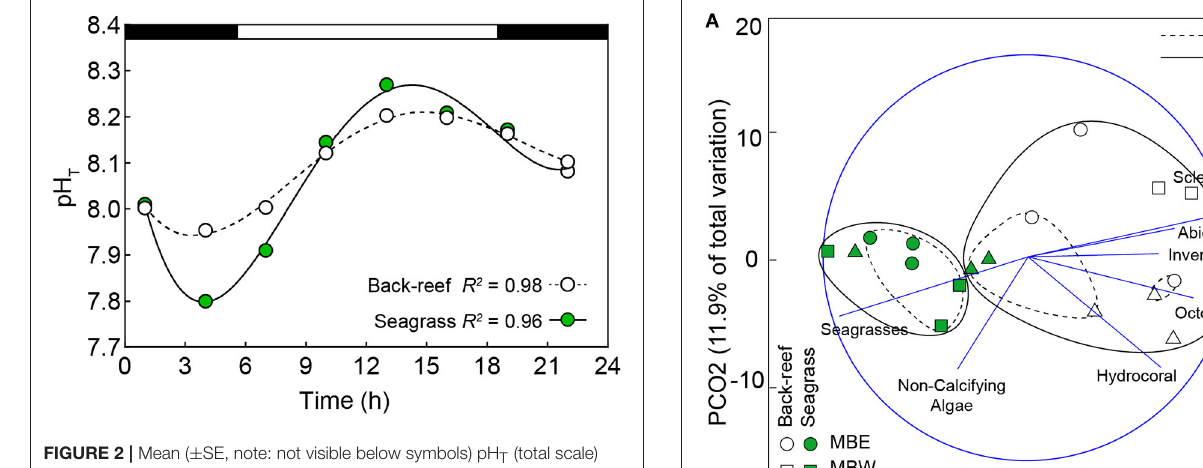
FIGURE 2 | Mean ( ± SE, note: not visible below symbols) pH T (total scale) values for the back-reef (open symbols) and seagrass habitats (green symbols) obtained at eight-time points over a full night (black horizontal bar) and day (white horizontal bar) cycle (discrete water samples: n = 432). R 2 produced by fitting the data to a fourth order polynomial function ( Y = a + bx + cx 2 + dx 3 + ex 4 ).